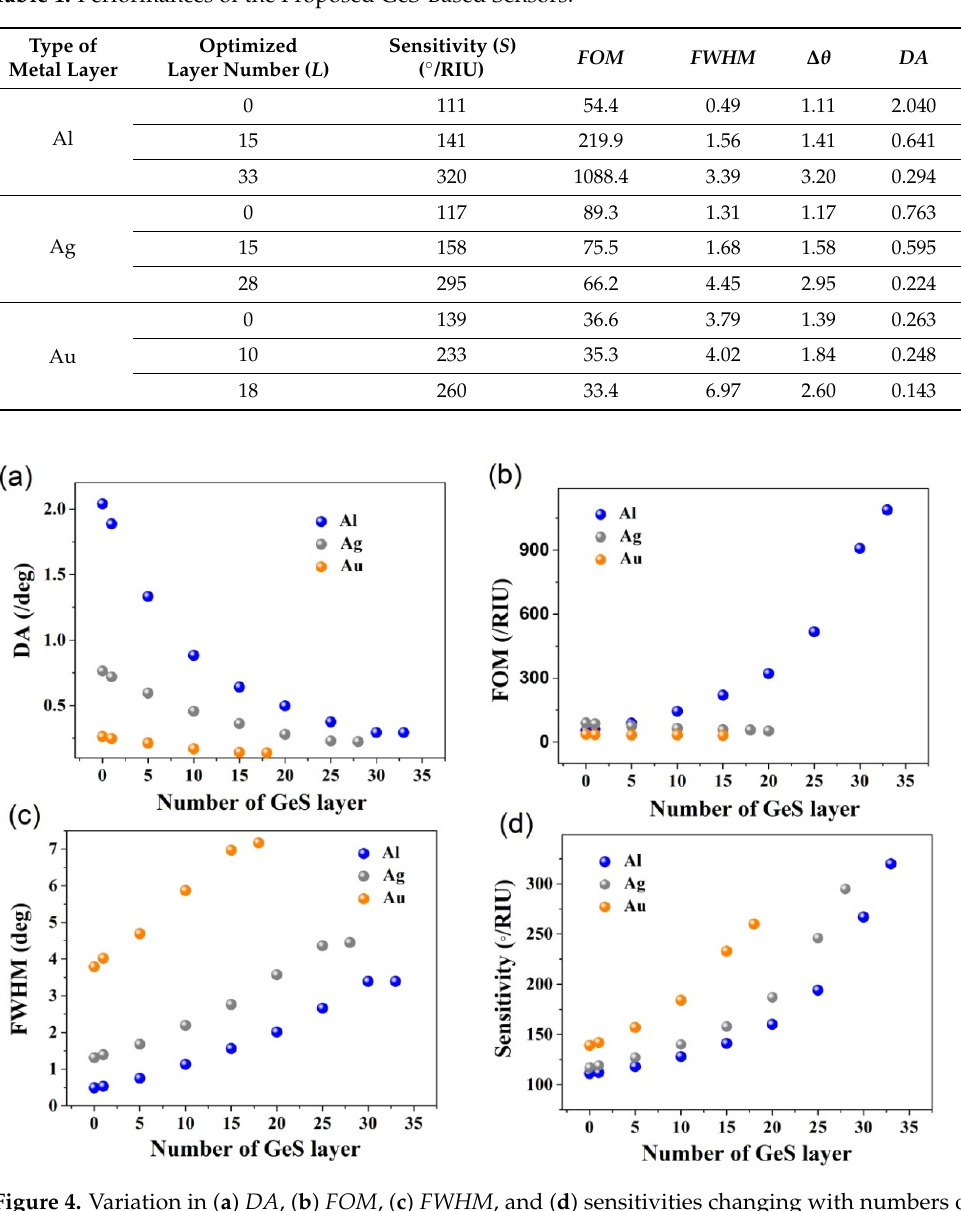
Table 1. Performances of the Proposed GeS-Based Sensors.